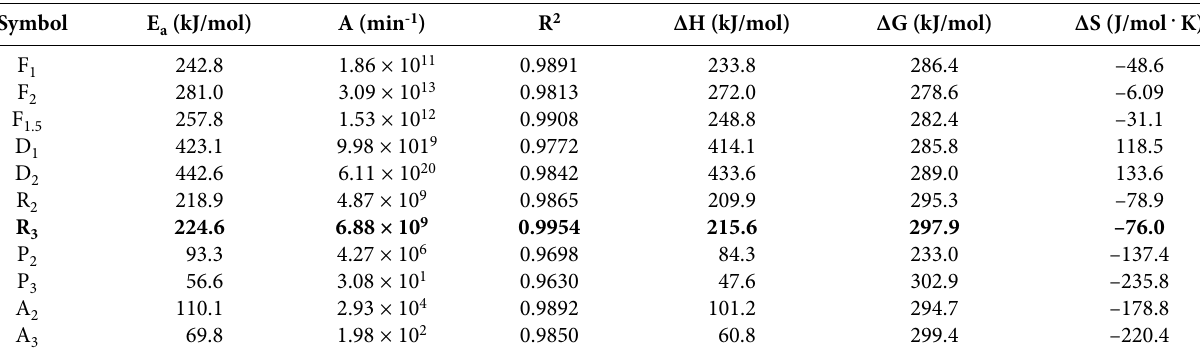
Table 2. Kinetic calculation results for thermal decomposition of CaCO 3 using the Coats–Redfern method. Symbol E a